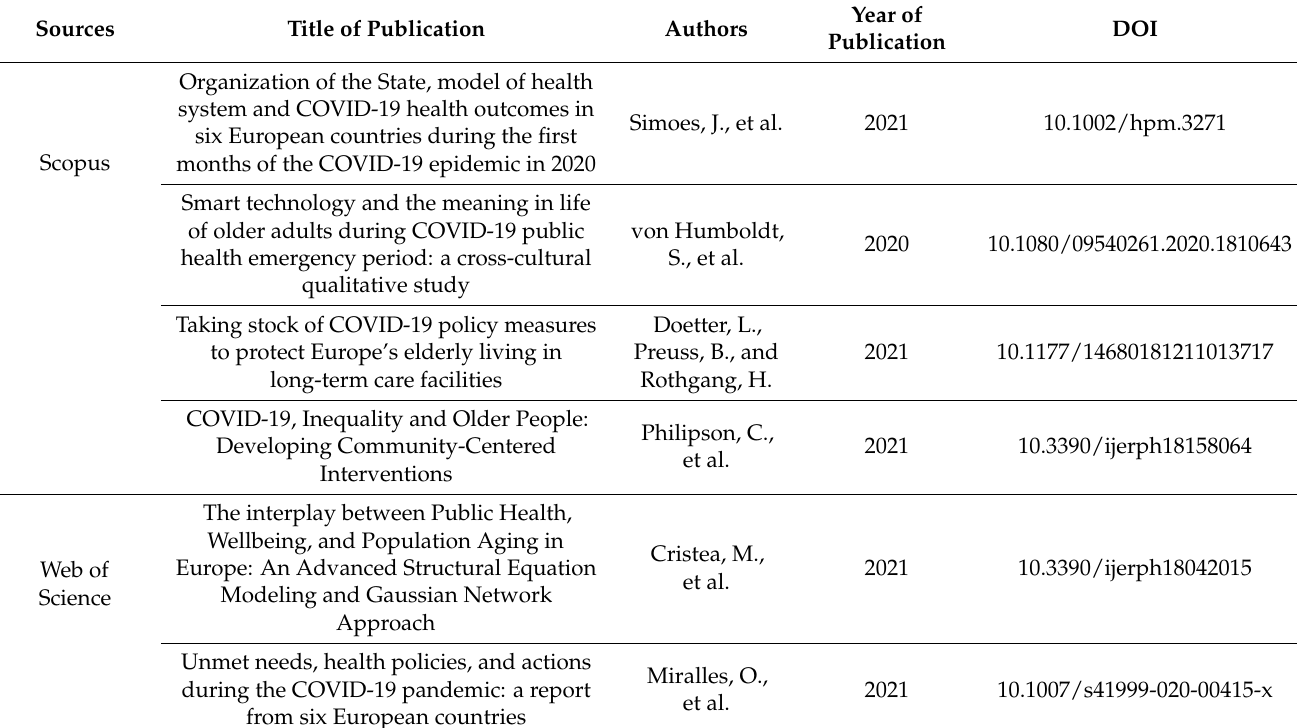
Table 2. The six articles referring to indicator (c) “works that make the comparison between different European welfare states, and the way they saw the protection of the older people, with the emergence of